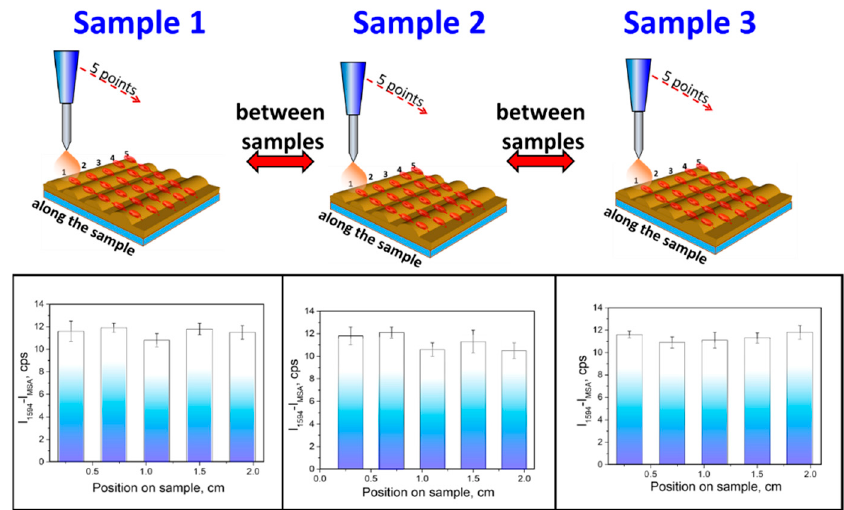
Figure 8. Test of functionalized SERS substrate reproducibility during sensing of Hg 2+ —variation of 1594 cm − 1 (C=O stretch) peak intensity along the one sample surface (error bars) and between the different samples (column height).